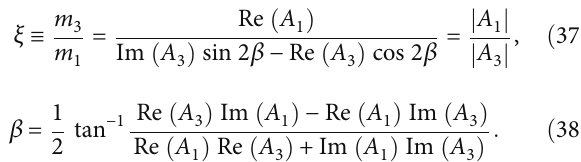
σ C.L. (only neutrino oscillation data are